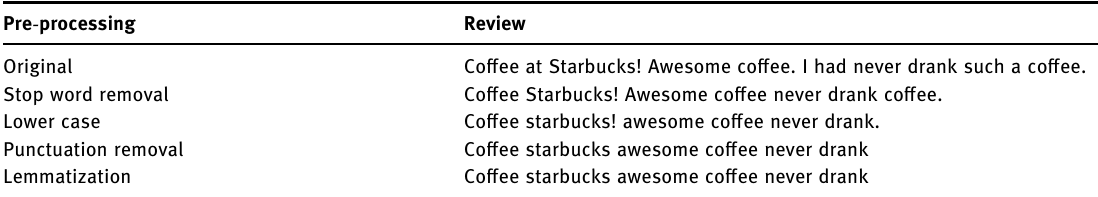
Table 1: Pre - processing example Pre - processing